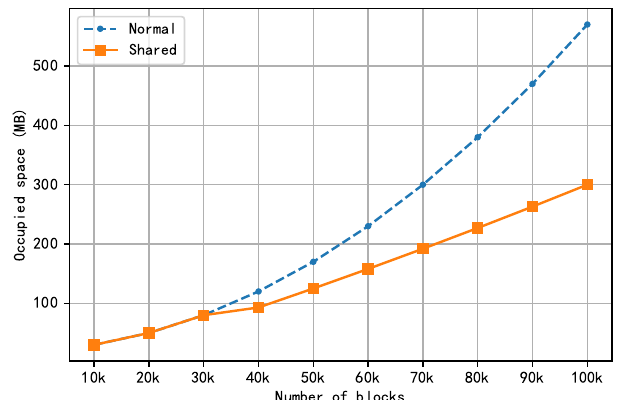
Figure 11. Comparison of the space occupation between shared storage and common storage.